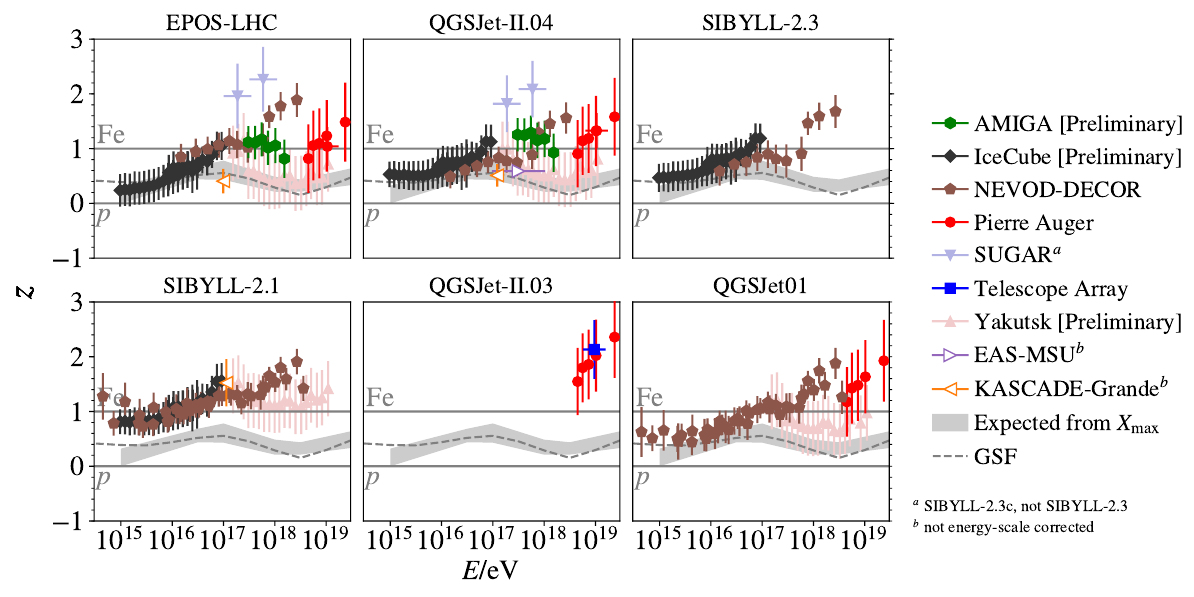
Figure 7. Data from Fig.6 after applying energy-scale cross-calibration. The points for KASCADE-Grande and EAS-MSU cannot be cross-calibrated and are only included for comparison. Shown for comparison are z -values expected for a mixed composition from optical measurements (band), based on an update of the review by Kampert and Unger [1] by the original authors of that paper, and from the GSF model (dashed